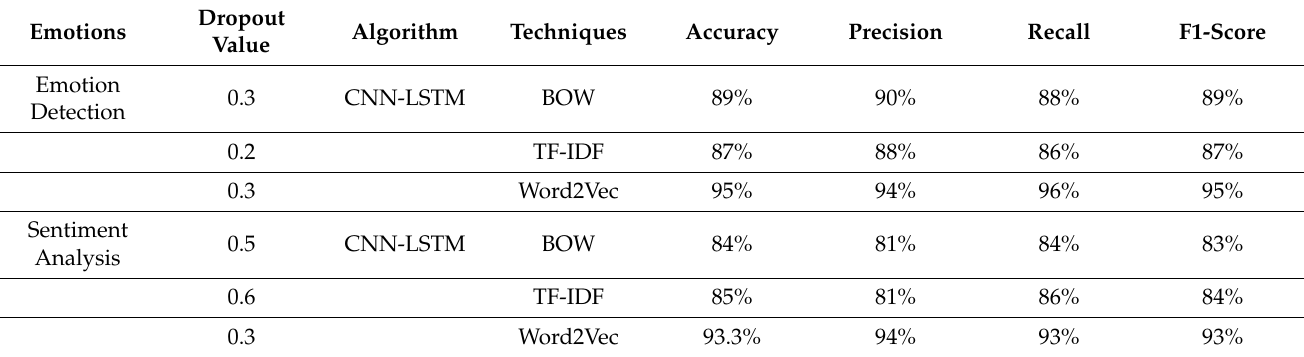
Table 9. Achieved Accuracy using Dropout values.